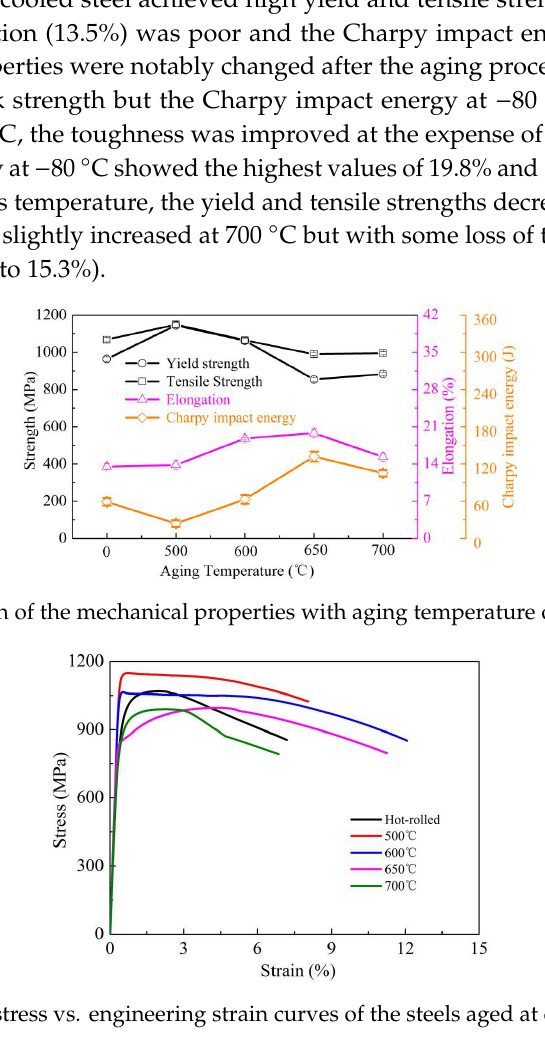
Figure 3. Engineering stress vs engineering strain curves of the steels aged at different temperatures.